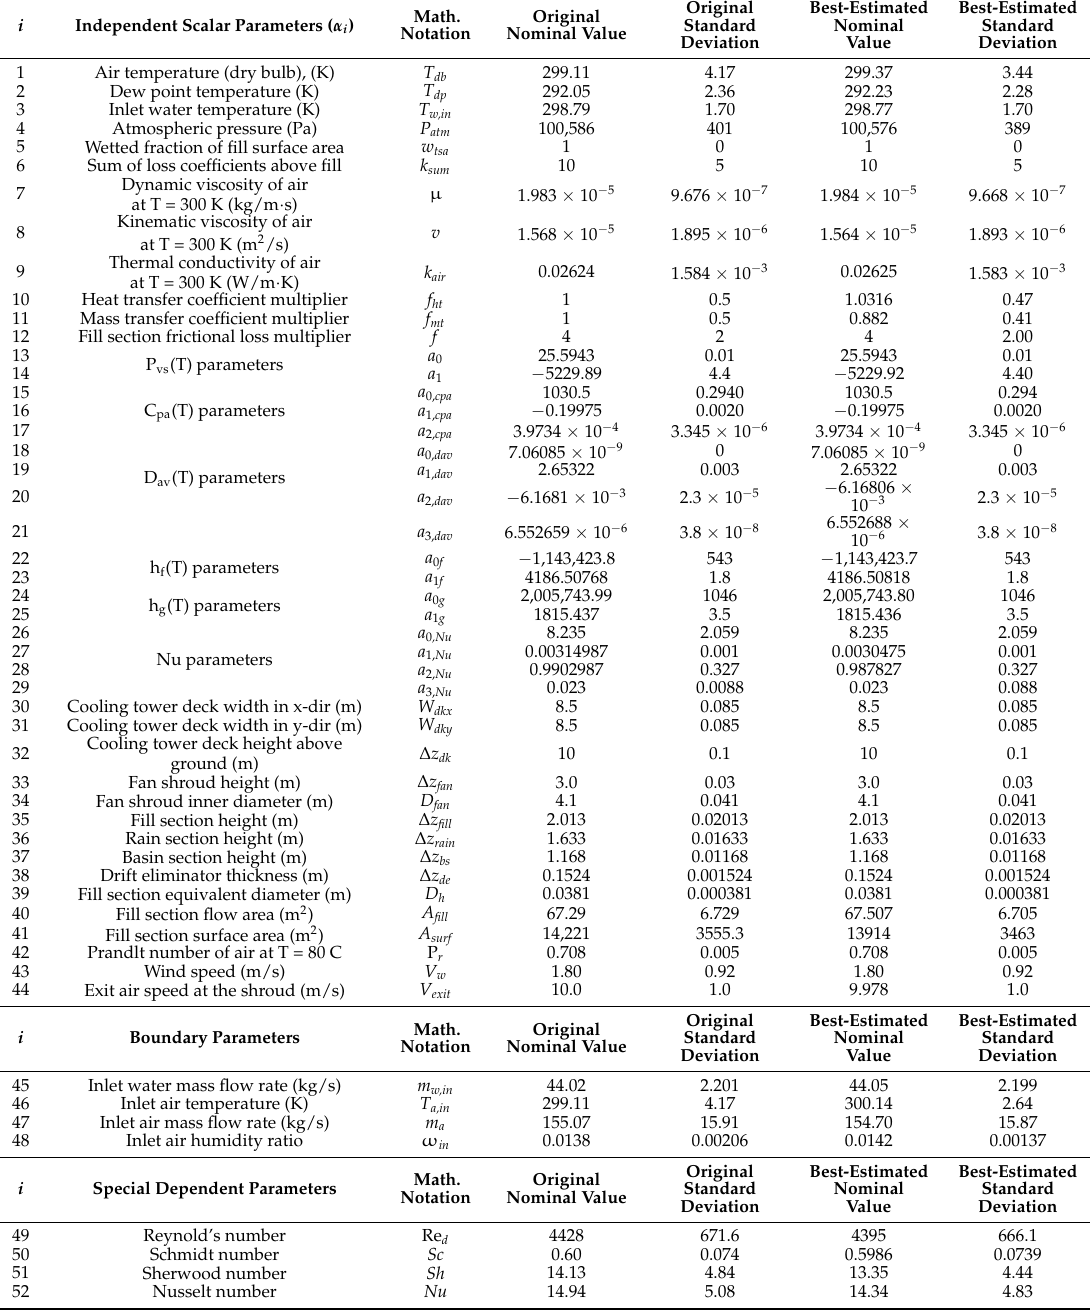
Table 5. Best-estimated nominal parameter values and their standard